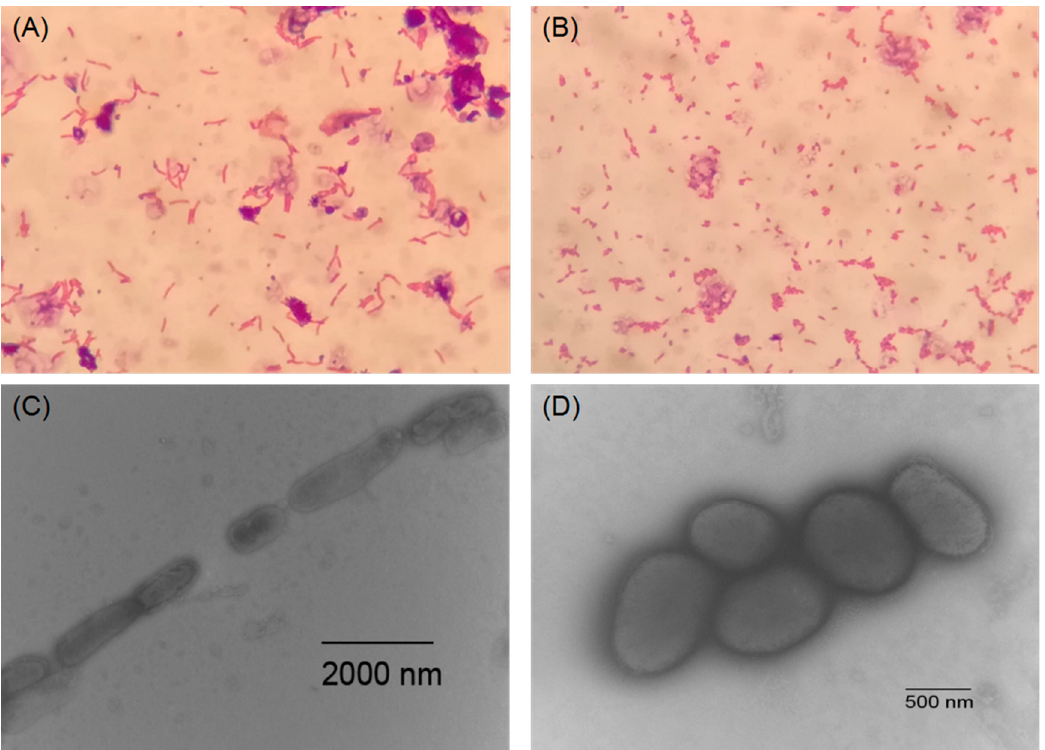
Figure 1. The morphological characteristics of strain NEAU-HV1 T on NA agar. ( A , B ) represent the light micrographs of Gram-staining cells of strain NEAU-HV1 T after incubation for 12 and 24 h, respectively. ( C , D ) represent the transmission electron micrograph of negatively staining cells of strain NEAU-HV1 T after incubation for 12 and 24 h, respectively. Table 1. Differential characteristics between strain NEAU-HV1 T and closely related members of the genus Sinomonas.